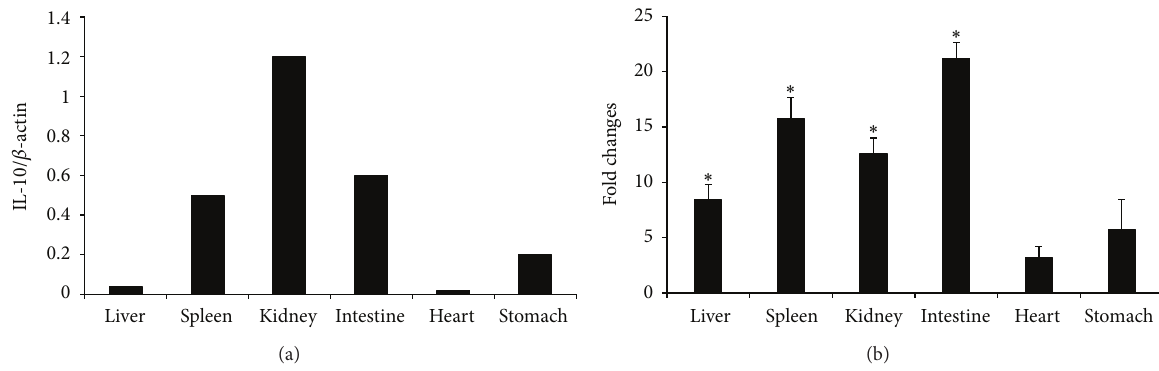
Figure 4: Expression analysis of frog IL-10 in different tissues from healthy frog (a) and LPS stimulated frog (b). Six tissues including liver, spleen, kidney, intestine, heart, and stomach were sampled for real-time PCR analysis. The mean ± SD values were shown. The transcripts levels of IL-10 in healthy frog were relative to those of 𝛽 -actin. The expression changes of IL-10 in LPS stimulated frog were expressed as fold change relative to the controls. 𝑃 values generated by paired sample 𝑡 -test between control and stimulated groups were shown above the bars. ∗ 𝑃 < 0.05 .